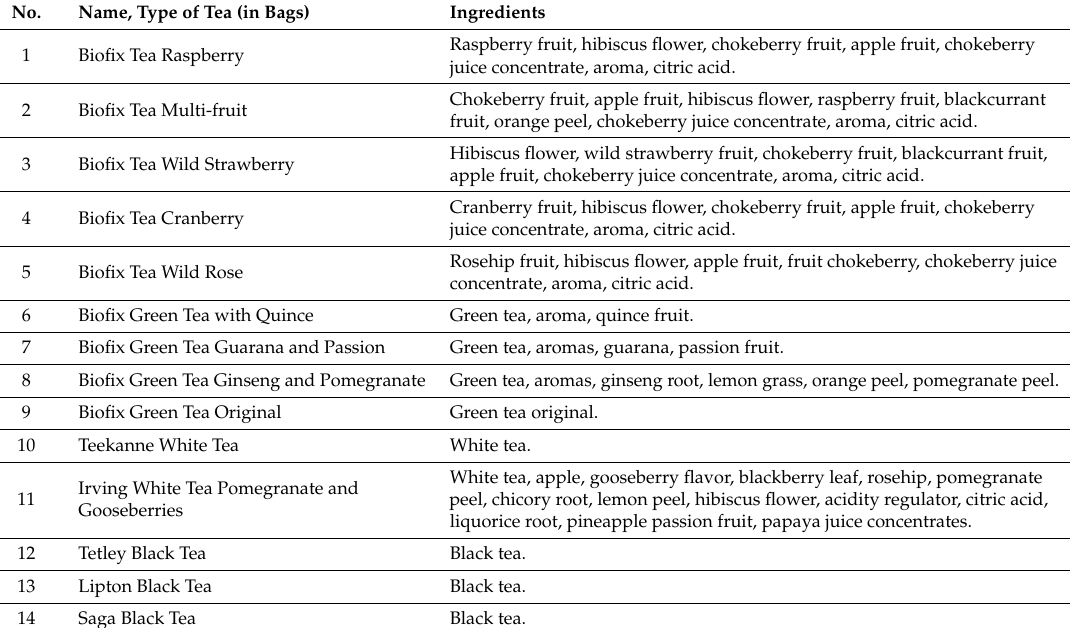
Table 1. Analyzed tea